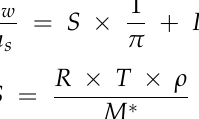
Figure 6. The room-temperature magnetization curve of the Fe 3 O 4 @CA MNPs (the line serves as a guide to the eye).